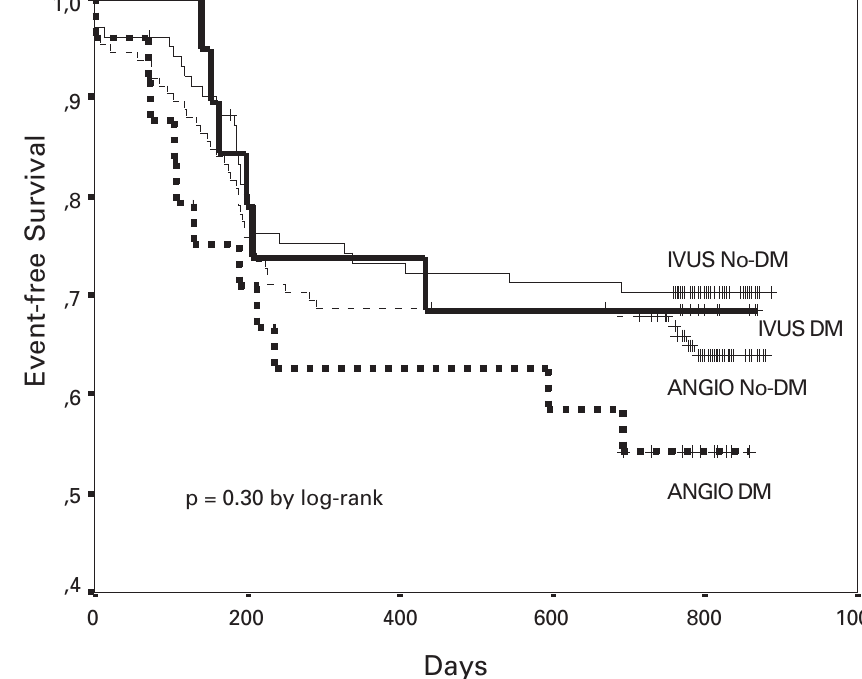
Event-free survival in diabetics with IVUS (IVUS DM), diabetics with ANGIO (ANGIO DM), and non-diabet- ics with IVUS (IVUS No-DM) or ANGIO (ANGIO No-DM). IVUS seems to atten- uate the negative ef- fect of